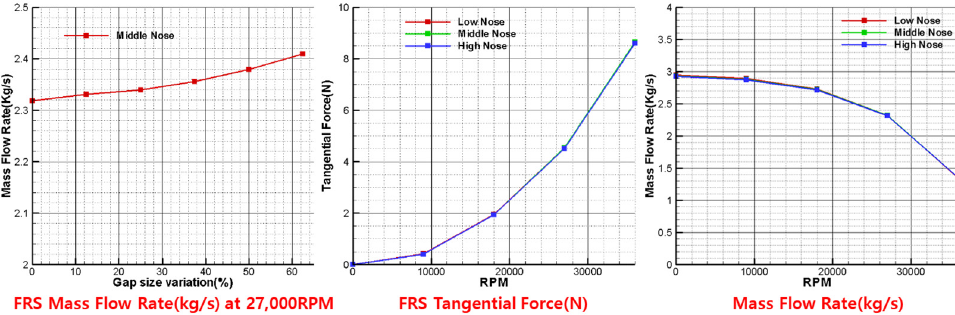
Figure 16. Mass flow rate and tangential force of floating ring with gap size and rotating speed.